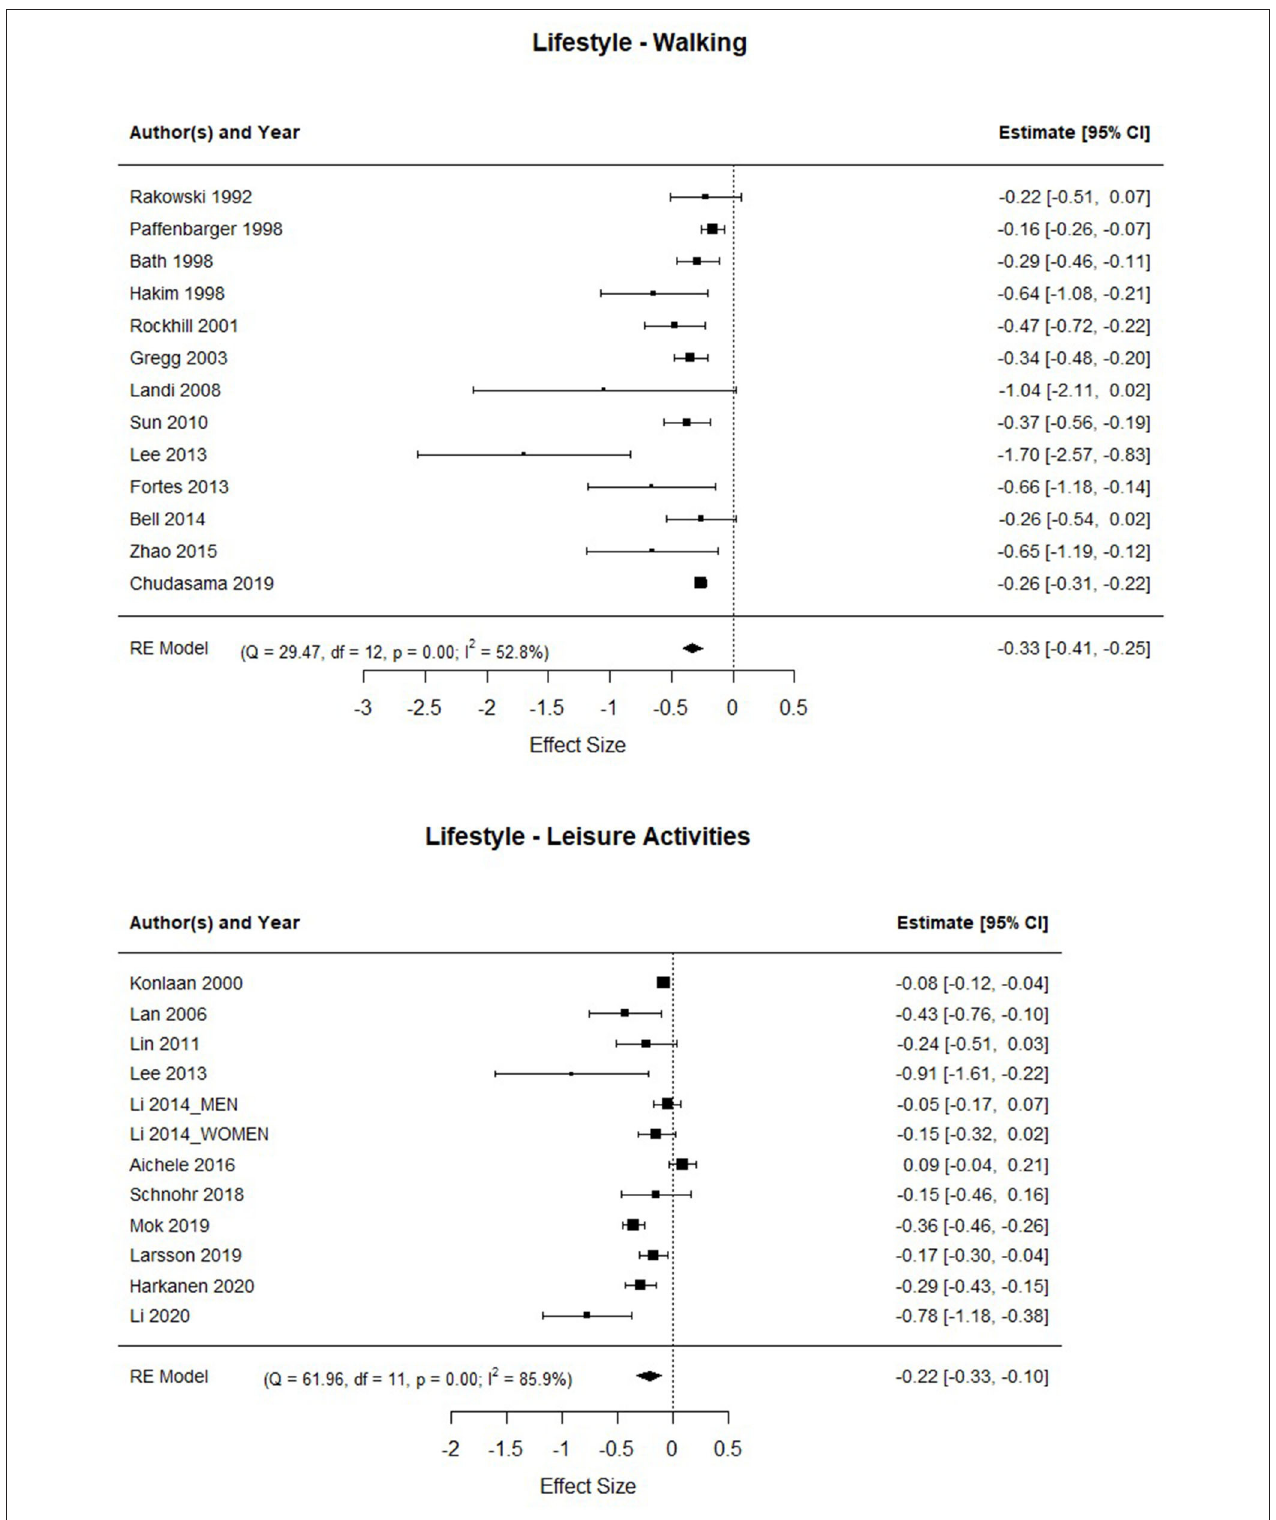
FIGURE 3 | Association between walking regularly, and performing leisure time activities, and the risk of mortality.